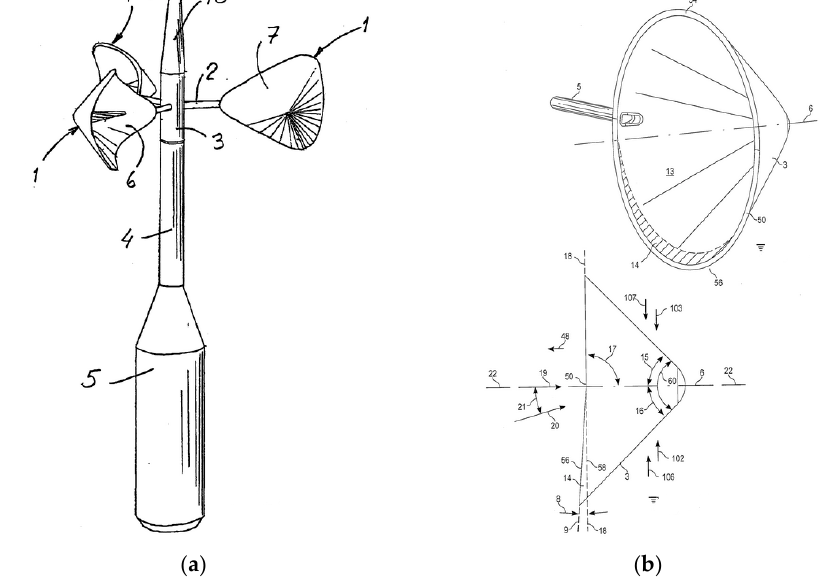
Figure 12. Examples of cups anemometer rotor design. Design by Dahlberg (Patent No.: US 2004/0083806 A1) ( a ), and design by Hong (Patent No.: US 2012/0266692 A1) ( b ).